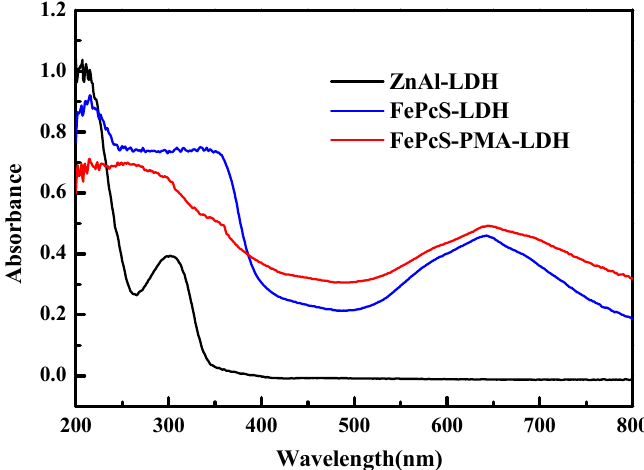
Figure 6. Di ff use reflectance spectra of ZnAl–LDH, FePcS–LDH, and Figure 6. Diffuse reflectance spectra of ZnAl–LDH, FePcS–LDH, and FePcS–PMA–LDH.